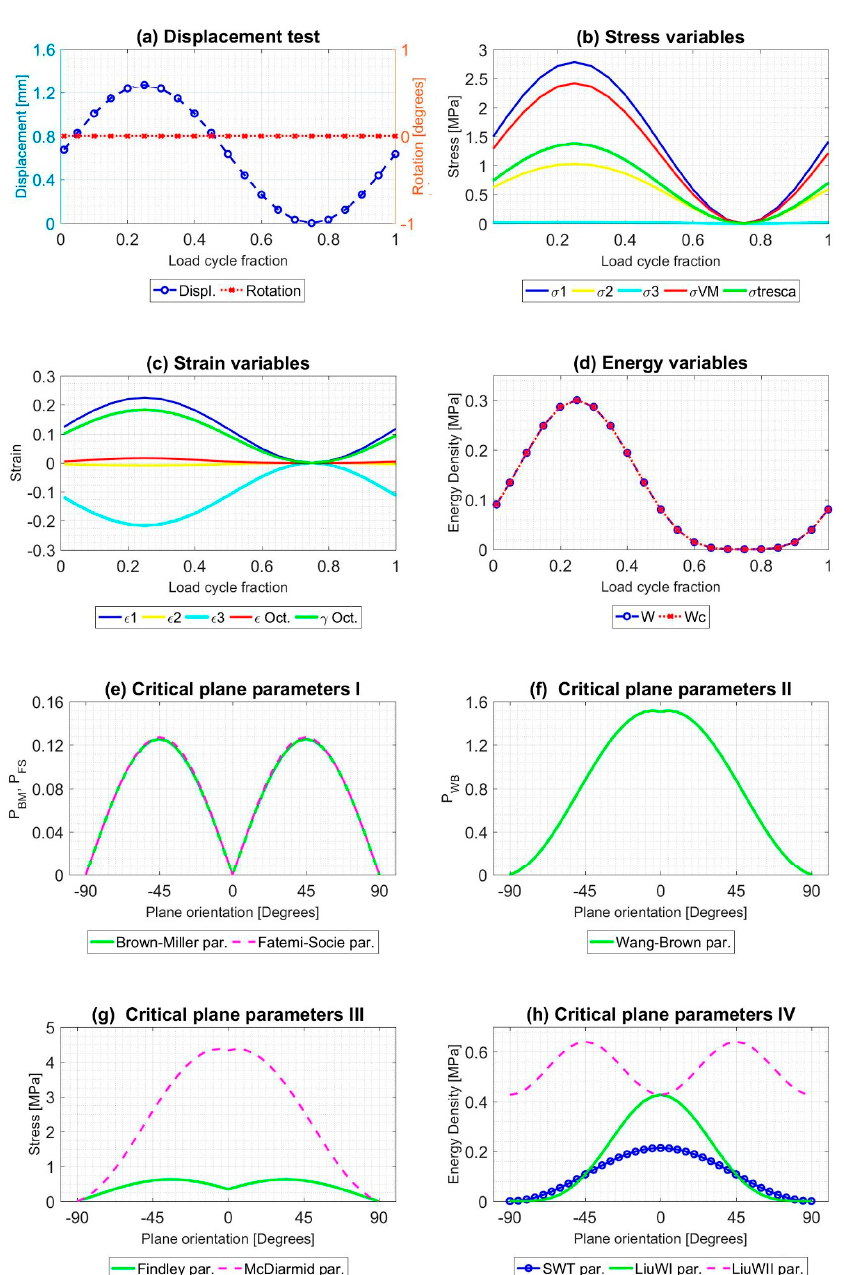
Figure 5. Result of the mechanical simulation of test A1 at the failure point of the sample caused by fatigue. Initial data from [45]